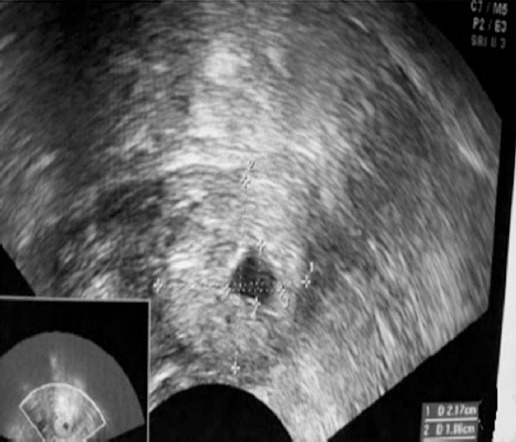
Results of transvaginal sonography: ectopic gestation mass in adnexa area; no obvious gestation sac echo; fuzzy boundary with ovary.